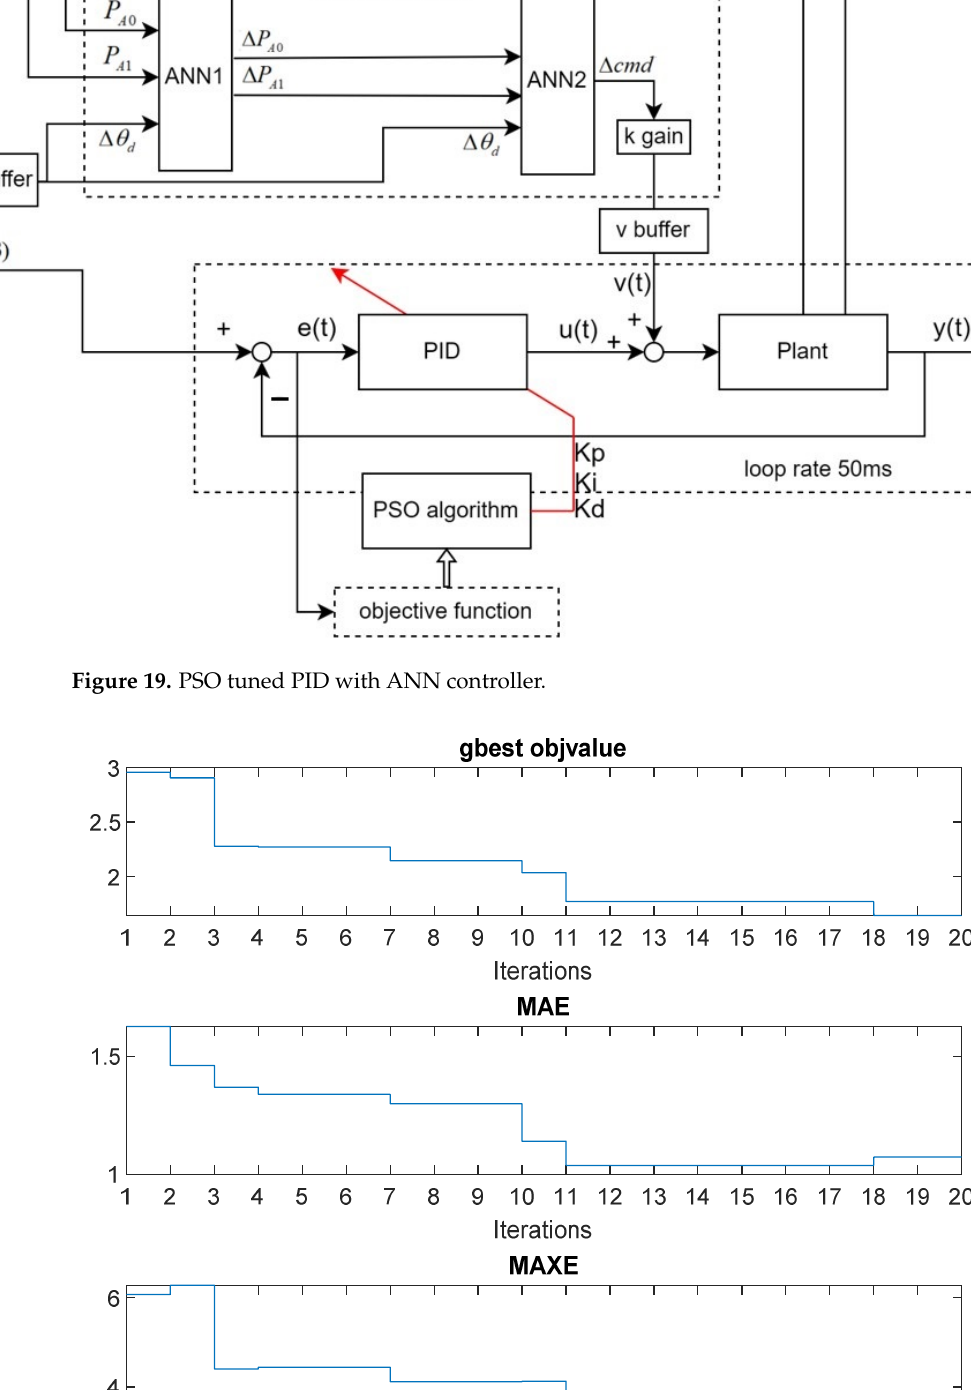
Figure 19. PSO tuned PID with ANN controller.